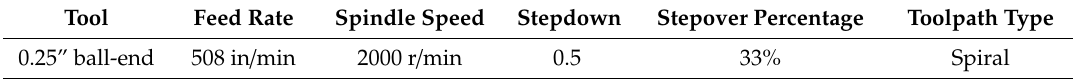
Figure 10. ( a ) Machining toolpath; ( b ) machining setup; ( c ) part after machining. Table 2. Pre-repair machining parameters for surface impact defects.